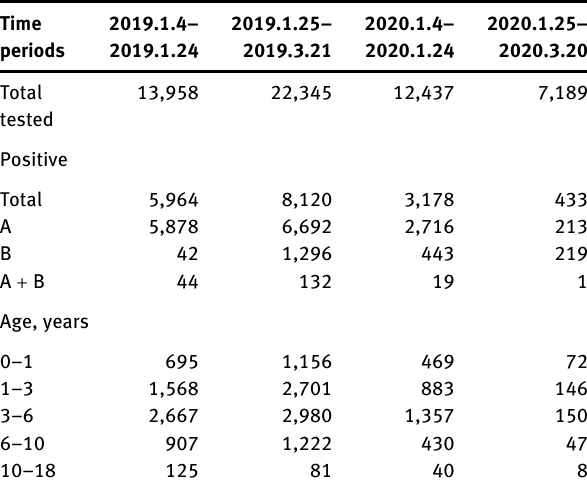
Table  : The number of children tested and positive for in fl uenza at different time periods and positive numbers at different ages.